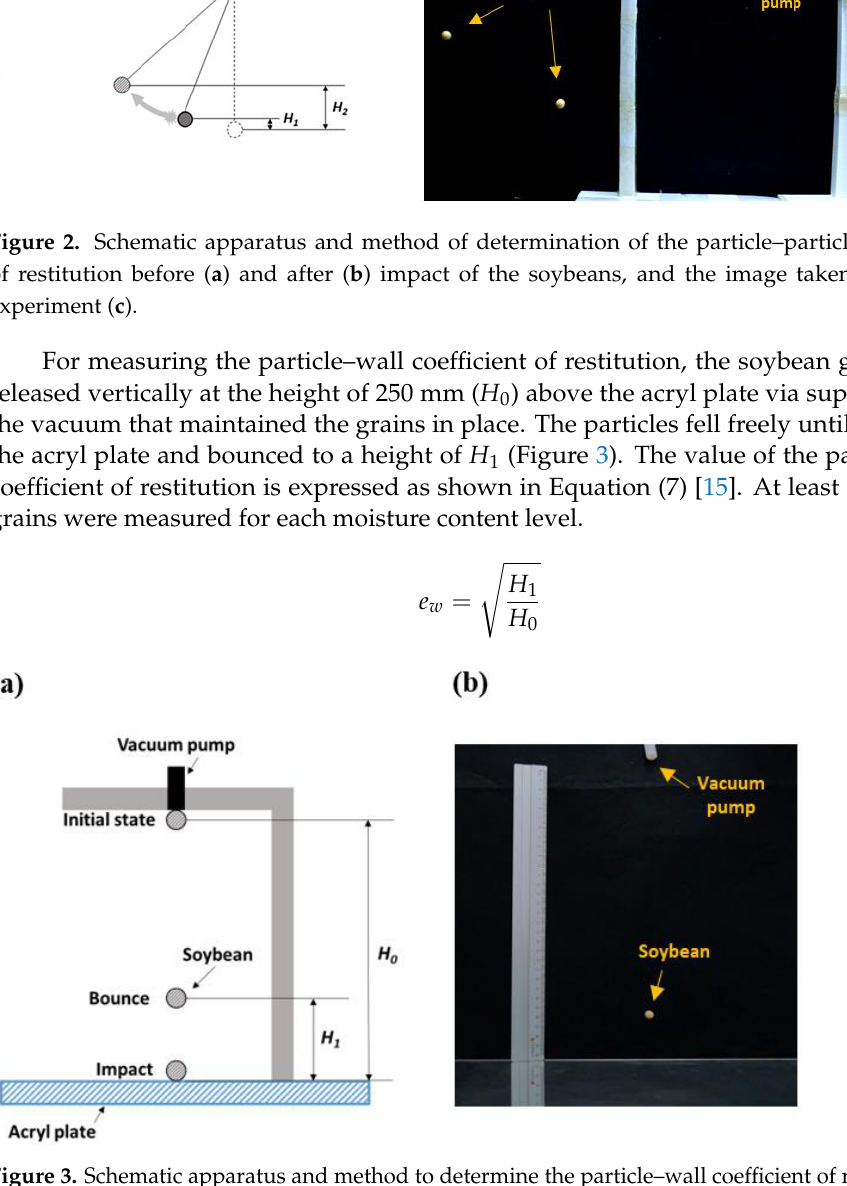
(9) Figure 4. Schematic drawing ( a ) and image ( b ) of the apparatus to measure the coefficient of rolling friction.